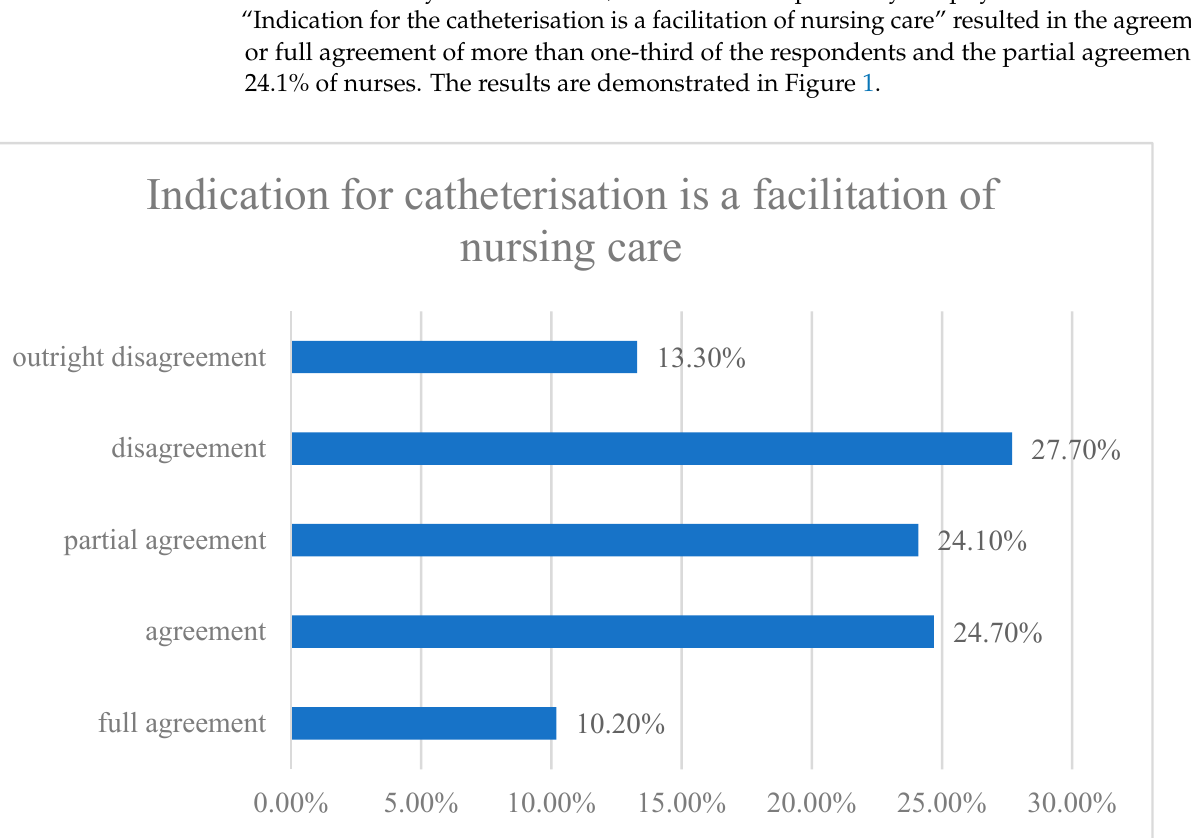
Figure 1. Overview of the responses to the statement “Indication for the catheterisation is a facilitation of nursing care”.